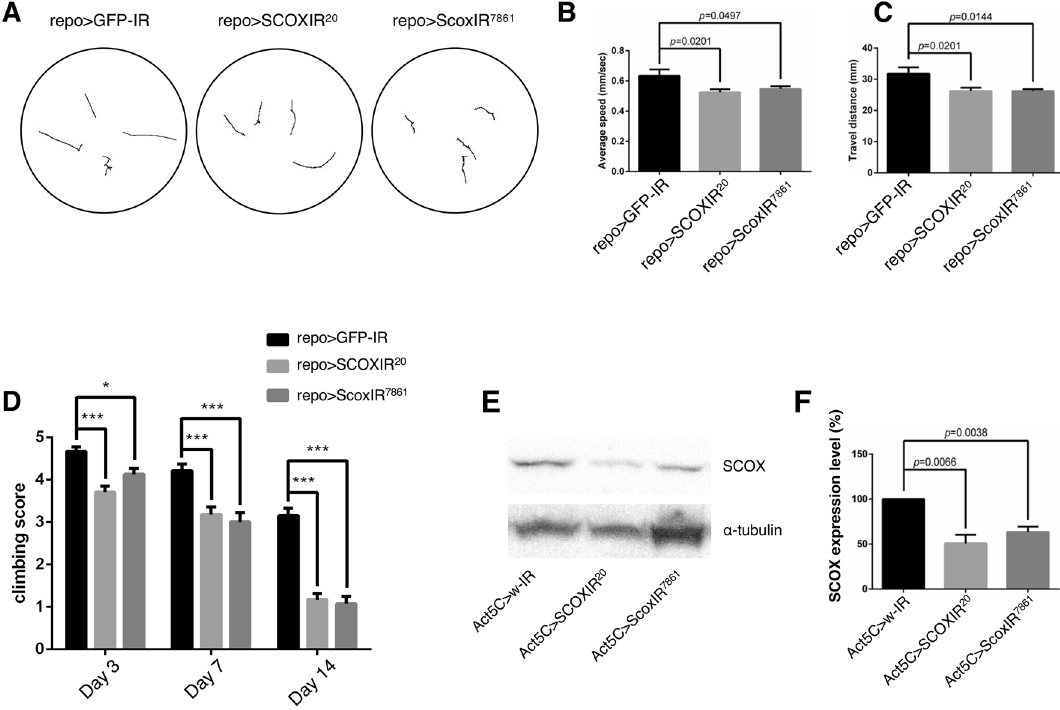
Figure 1. Glial cell-specific Scox knockdown reduces locomotive activity in larval and adult stages. The locomotive ability of larvae was tested in a crawling assay. ( A ) The crawling paths of male third instar larvae in the pan-glial cell-specific Scox knockdown. ( B , C ) Pan-glial cell-specific Scox knockdown reduces both the average crawling speed ( B ) and travel distance ( C ) compared with control. n = 20. ( D ) The locomotive ability of adult flies was tested in a climbing assay. Pan-glial cell-specific Scox knockdown reduced climbing scores compared with the control. Climbing assays were performed on days 3, 7, and 14 after eclosion, and climbing scores were calculated on each day. n = 100. * p < 0.05, *** p < 0.0001. ( E ) The expression level of SCOX was analyzed by Western blotting. Protein extracts from whole larvae were used. The expression levels of SCOX significantly decreased in both knockdown fly lines, as previously reported 11 . ( F ) Quantification of the expression levels of SCOX compared with α-tubulin. α-tubulin was used as an internal control and the relative intensities of SCOX bands normalized using α-tubulin are shown by each bar. In the SCOX knockdown larvae, expression levels of SCOX decreased compared with the control. n = 4. repo > GFP-IR ( UAS-GFP-IR/ + ; repo- GAL4/ +), repo > SCOXIR 20 ( UAS-SCOXIR 20 / + ; repo-GAL4/ +), repo > ScoxIR 7861 ( repo-GAL4/UAS-ScoxIR 7861 ), Act5C > w-IR ( Act5C-GAL4/ + ; UAS-w-IR/ +), Act5C > SCOXIR 20 ( Act5C-GAL4/UAS-SCOXIR 20 ), and Act5C > ScoxIR 7861 ( Act5C-GAL4/ + ; UAS-SCOXIR 7861 /